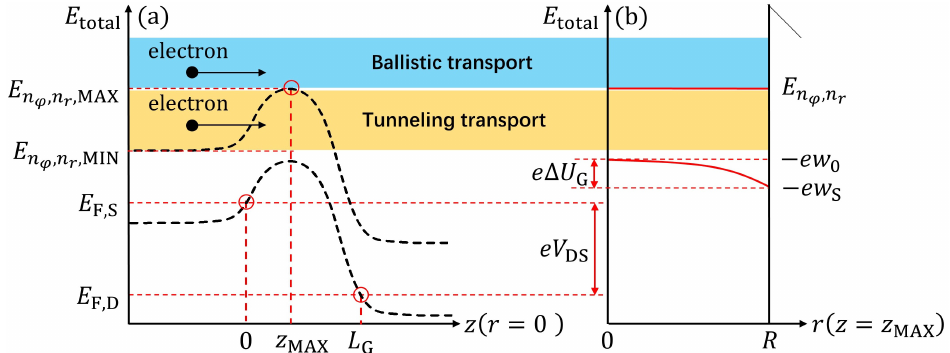
Figure 2. Rough sketch of the potential energy profiles along the channel and the transverse direc- tions, and mechanisms governing the carrier transport in ballistic tunneling and thermionic modes. ( a ) Representation of energy-level distribution along the z direction at the channel center ( r = 0). ( b ) Schematics of confinement potential energy distribution along the r direction at the barrier top ( z = z MAX ) in the cross-section. The elementary charge is denoted by e